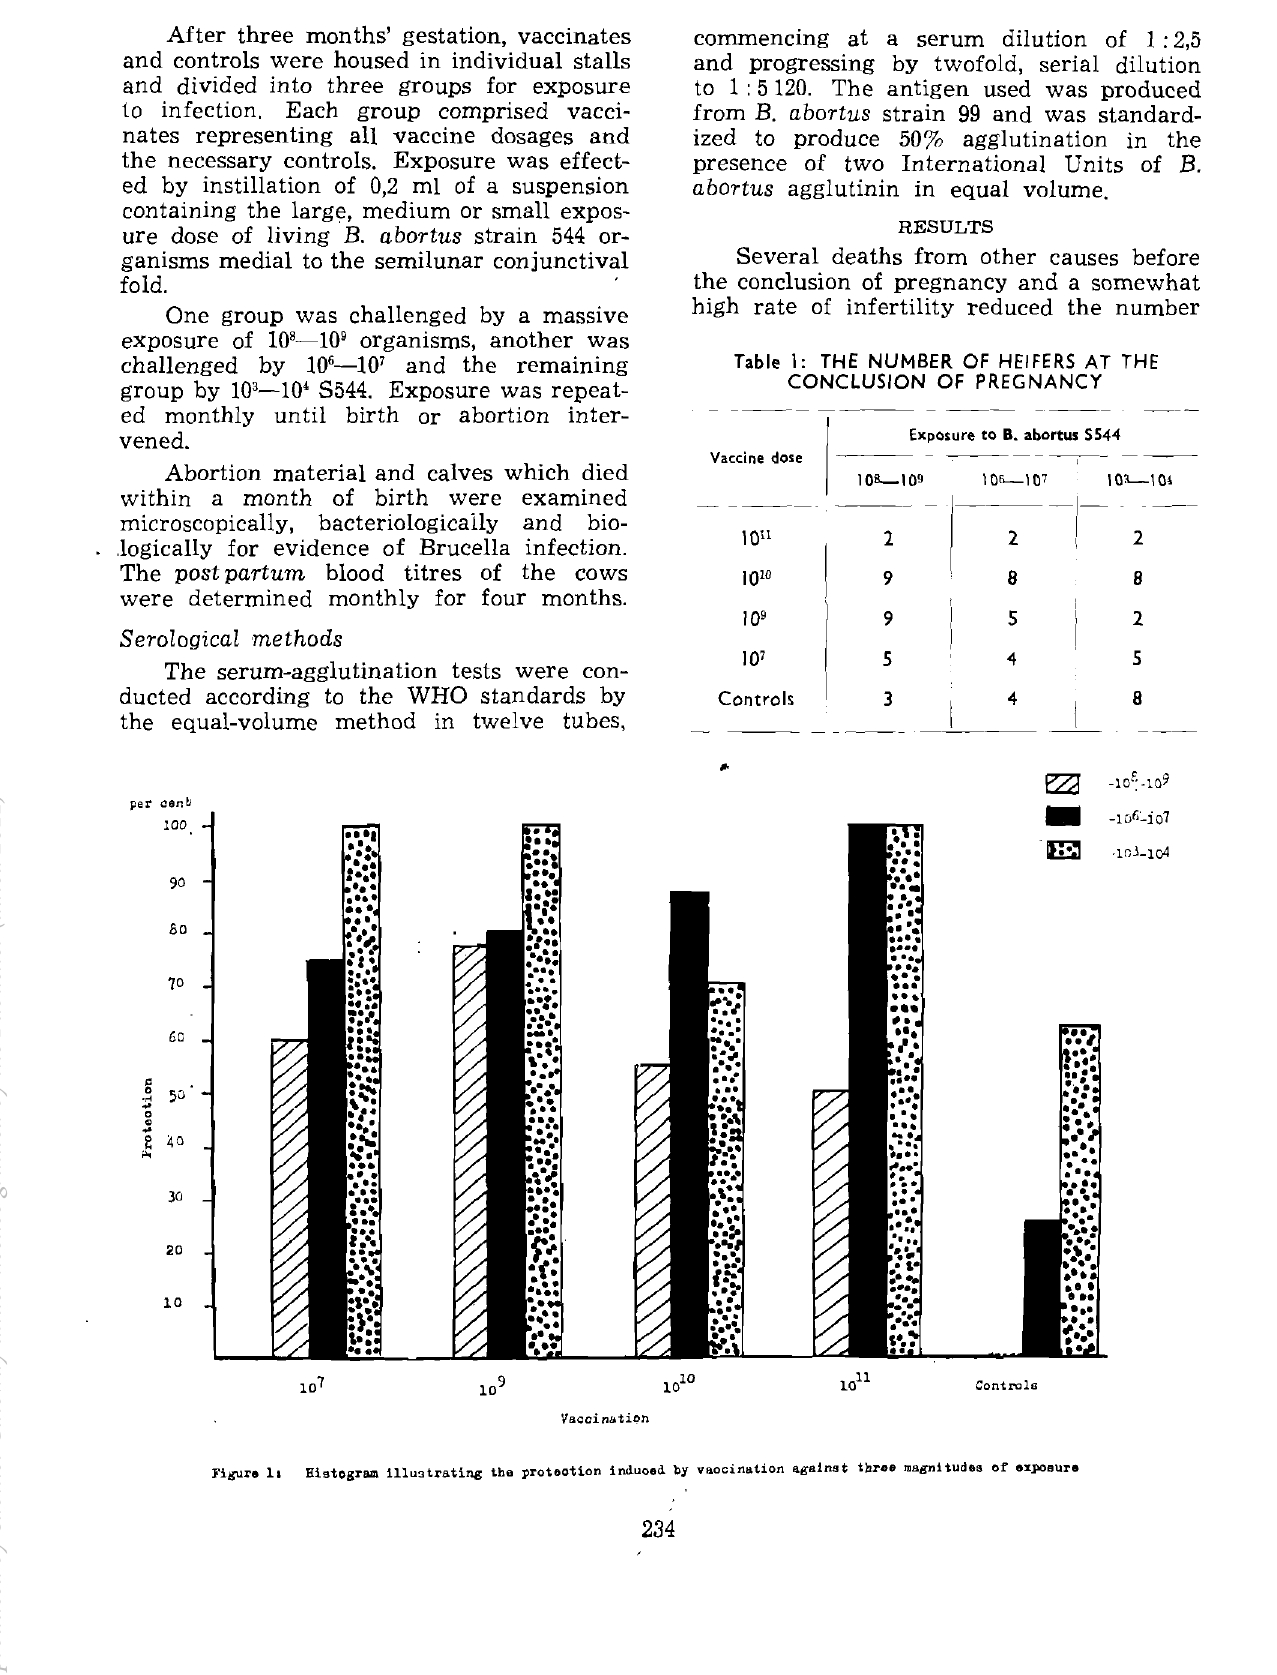
Figura 11 B1etos.ram illust.rating t.be prot.eation induoed. by vaooination _"Binet three mapit.ude. Dt I:QIOBura